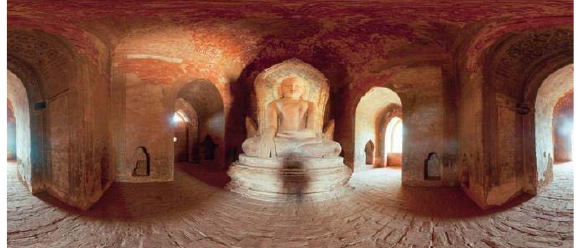
Figure 6. Panoramic image of the core buddha in Khe-Min-Ga- Zedi